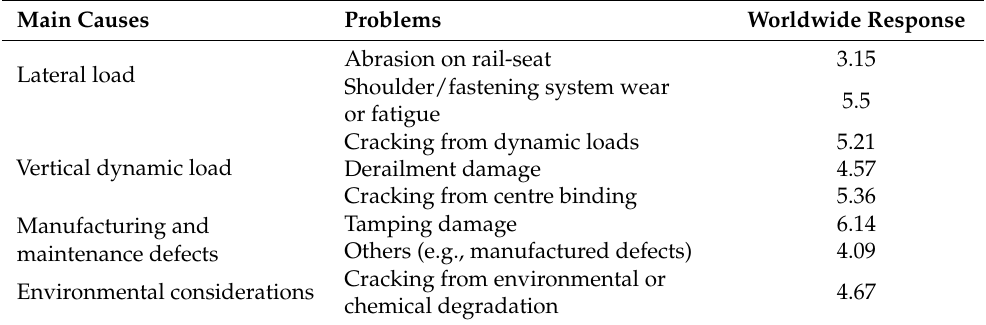
Table 1. Most critical causes of concrete sleeper failures (ranked from 1 to 8, with 8 being the most